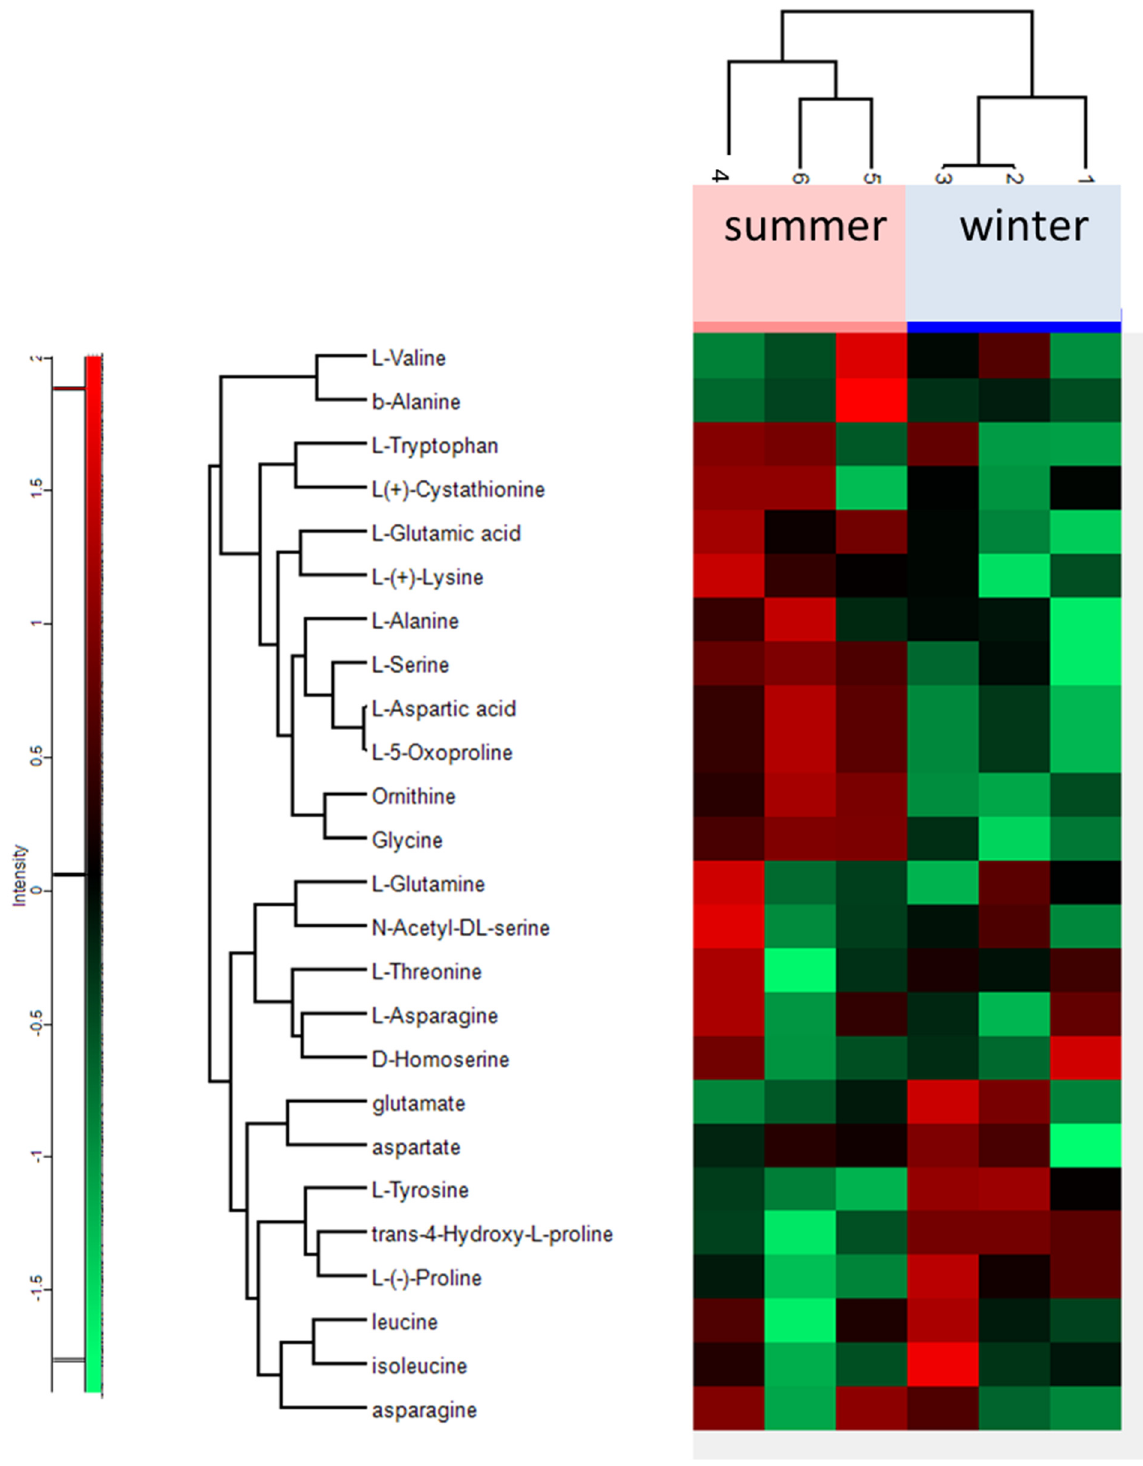
Figure 3. Heat map of amino acids and derivatives identified in the Cinara tujafilina bodies from summer and winter samples; red colour indicates metabolites with a high expression, green indicates metabolites with low